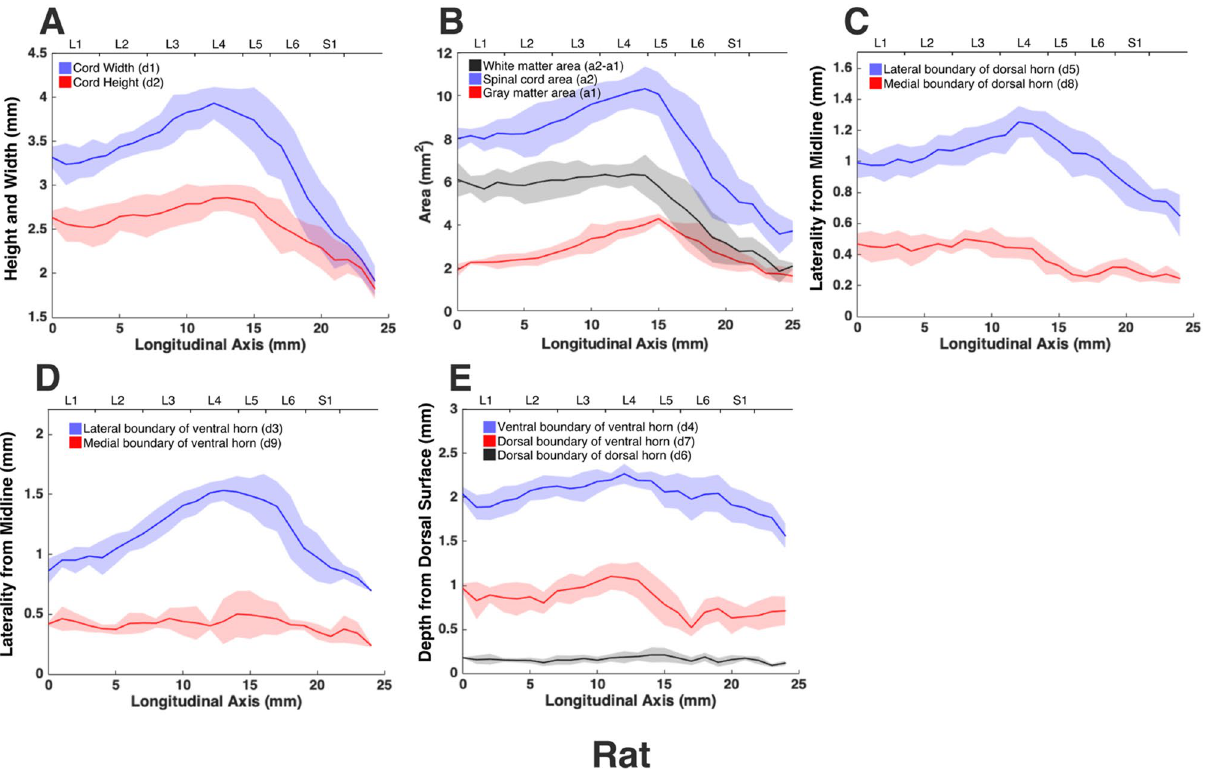
Figure 8. Measurements of cross-sectional dimensions of the spinal cord and locations of the ventral and dorsal horns of rat spinal cord. Presented data are based on n = 6 specimens. Solid lines represent the mean and the shaded regions represent the mean ± standard deviation. ( A ) Spinal cord width and height (d1 and d2, respectively in Fig. 7, left) across the lumbosacral cord. ( B ) Cross-sectional areas of the spinal cord and gray matter (a1, a2 in Fig. 7, right) across the lumbosacral cord. ( C ) Lateral distances from midline of dorsal horn boundaries (d5, d8 in Fig. 7, middle). ( D ) Lateral distances from midline of ventral horn boundaries (d3, d9 in Fig. 7, middle). ( E ) Depth from the dorsal surface of the spinal cord of the ventral and dorsal horn boundaries (d4, d7, d6, in Fig. 7,